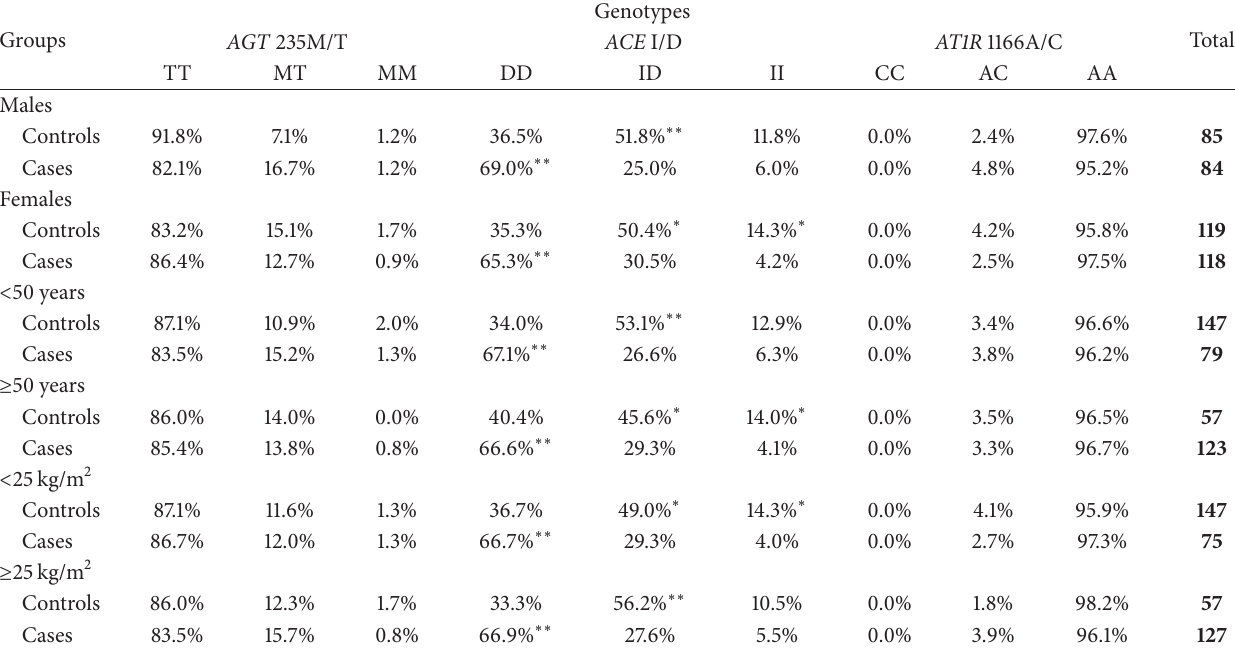
Table 3: Genotypes distribution among study population groups.